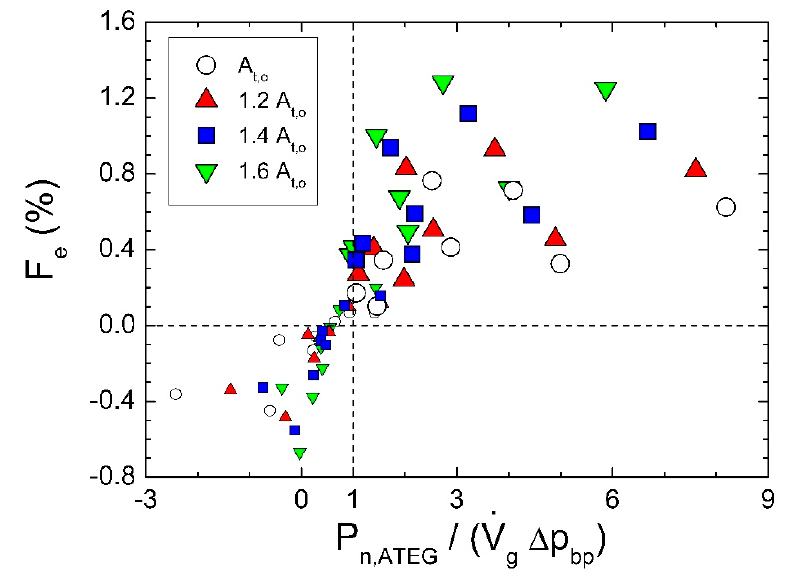
Figure 17. Fuel economy as a function of the net output power to exhaust gas flow power ratio for all cases analyzed. Small symbols: ZT e = 0.21. Large symbols. ZT e = 0.63. Numerical results.